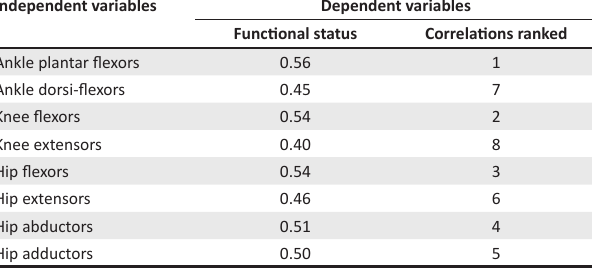
TABLE 4: Order of contribution of muscle groups to lower limb function in HIV- positive cohort.